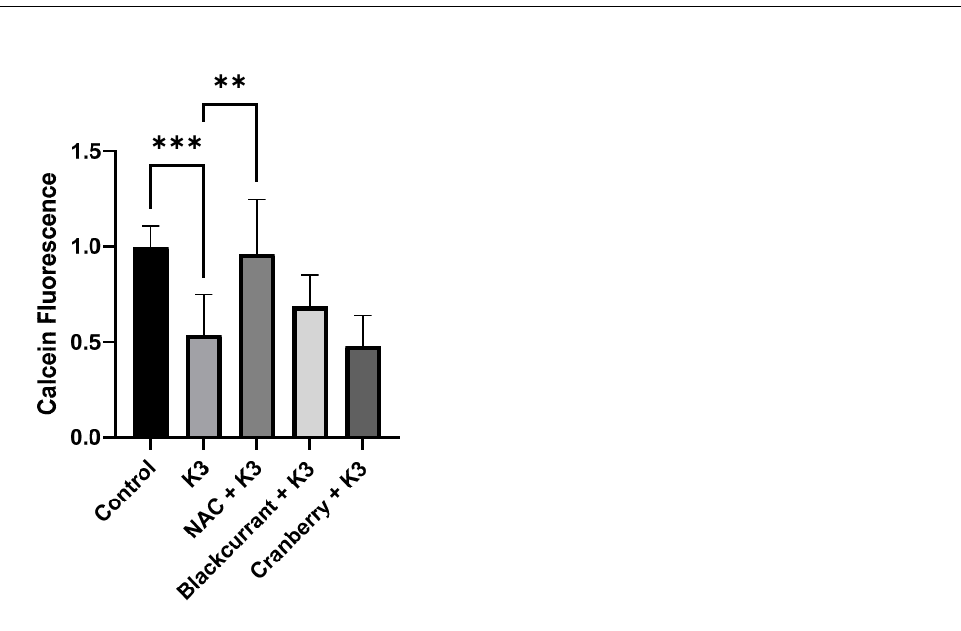
Figure 3. Effects of berry extracts on cell viability in HL-1 cells. Shown are normalized results of calcein-AM staining of live cells following treatments as indicated. As expected, K3 induced a significant reduction in cell viability (*** p < 0.001), whereas 1 mM NAC significantly inhibited K3-induced cell death (** p < 0.01). Although neither berry extract significantly affected cell viability, black currant extract (100 µg/mL) offered modest protection when compared to cranberry extract (100 µg/mL) which offered no protection from cell death caused by K3.